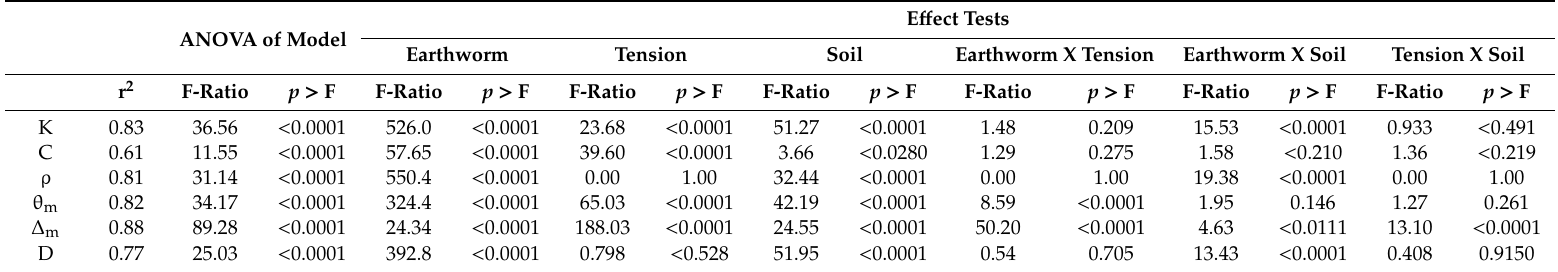
Table A1. ANOVA parameters for linear model for entire model and individual e ff ects of heat capacity, C, thermal conductivity, K, density (including soil moisture), ρ , mass moisture, θ m , mass of water loss between soil tensions, ∆ m, and thermal di ff usivity,